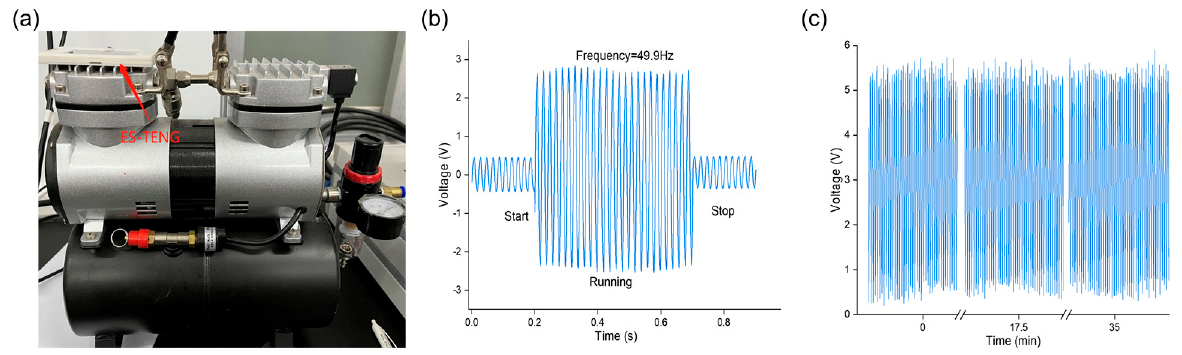
Figure 6. Practical application of ES − TENG. ( a ) ES − TENG installed on the air compressor; ( b ) monitoring of the working condition of the air compressor; ( c ) endurance test results.